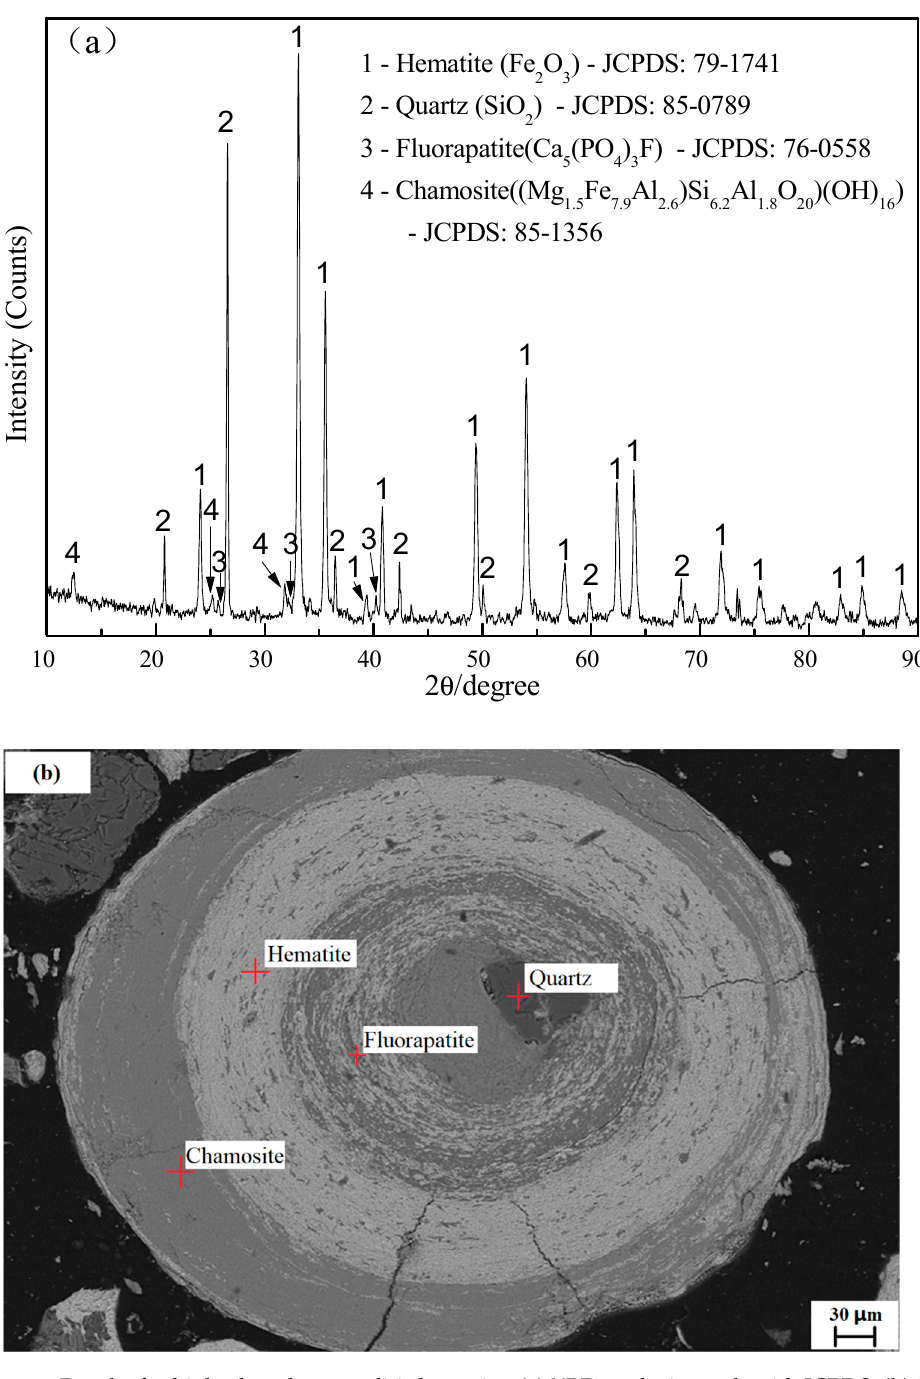
Figure 1. Results for high-phosphorus oolitic hematite. ( a ) XRD analysis result with JCPDS; ( b ) SEM image. JCPDS: Joint Committee on Powder Diffraction Standards.